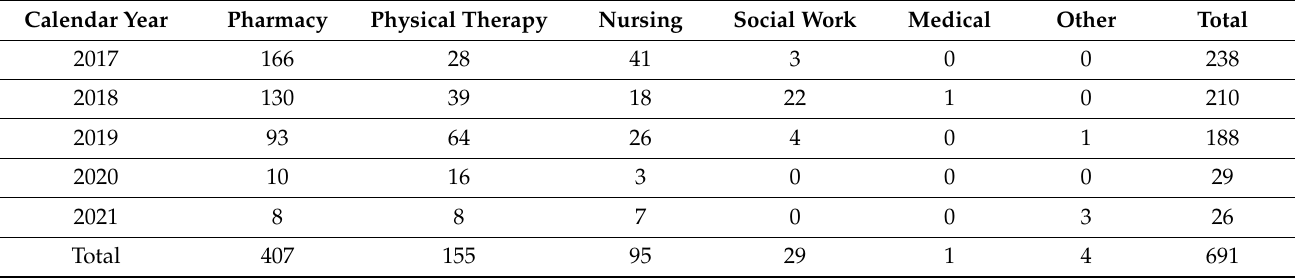
between 2017–2021. Table 3. Number of students’ professions and participation by year between